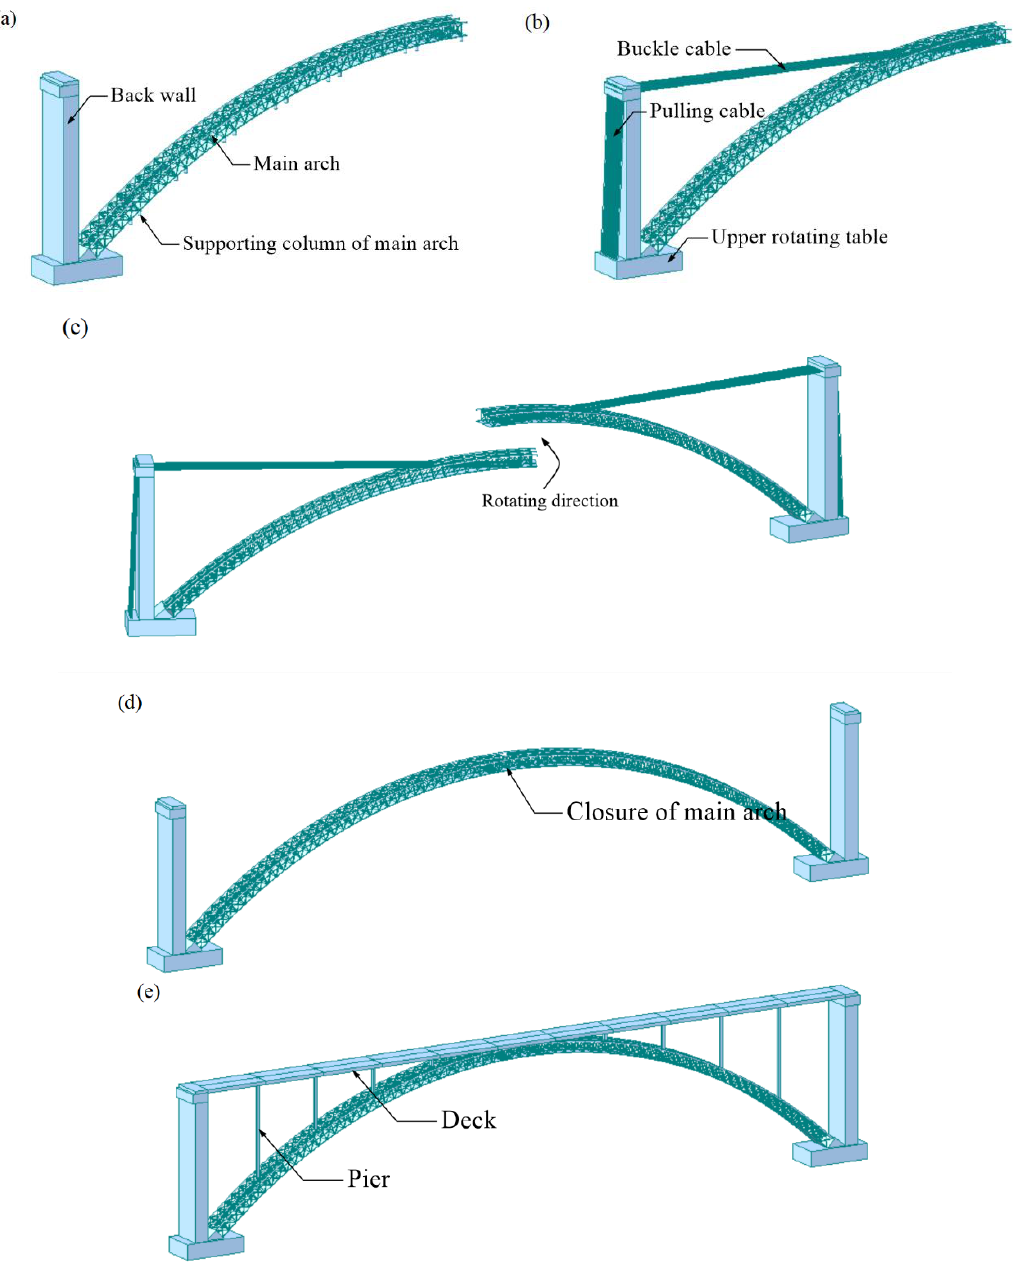
Figure 3. Construction process ( a ) main arch construction; ( b ) cable tension; ( c ) rotating process; ( d ) closure of main arch; ( e ) pier and deck construction.